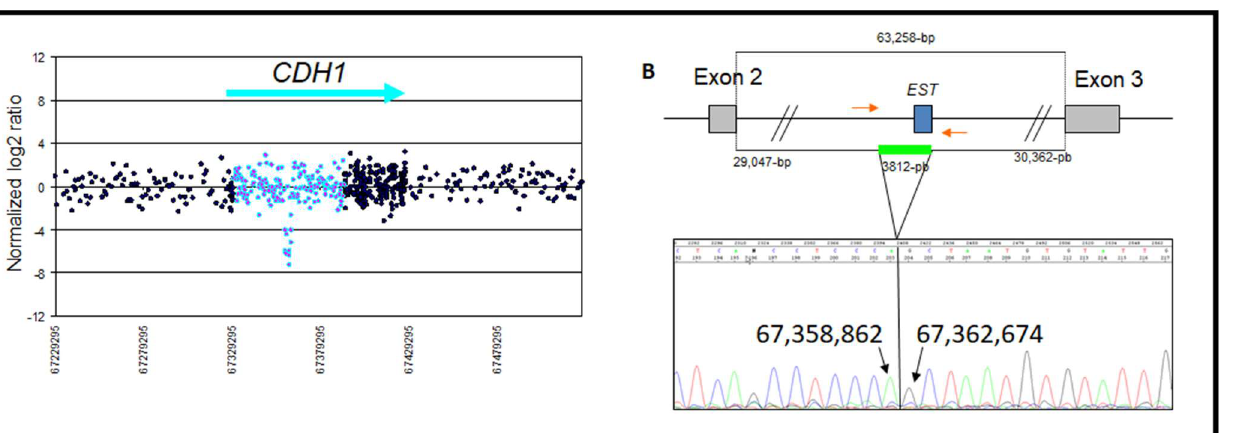
Figure 2. ( A ) Array CGH profile obtained for the heterozygous exon 3 deletion of the CDH1 gene. Intron 2 is represented in blue dots. ( B ) Sequencing chromatogram of the mapped breakpoint for the exon 3 deletion from chr16: 67,387,135 to 67,394,109. Gray box: exons; green line: deletion locus. Red arrows: position of sequencing primers.